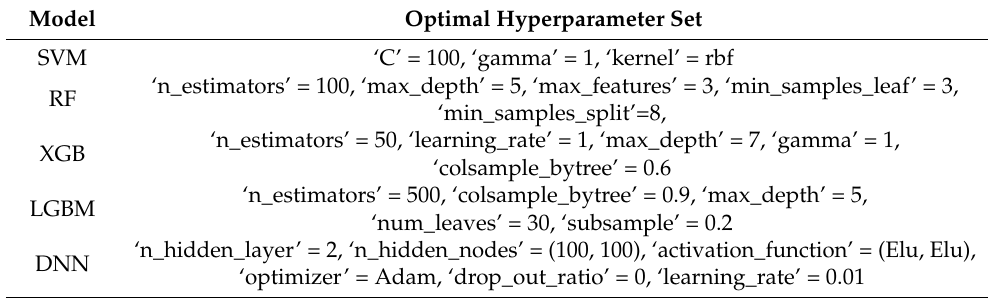
Table 2. Optimal hyperparameters for the ML methods.